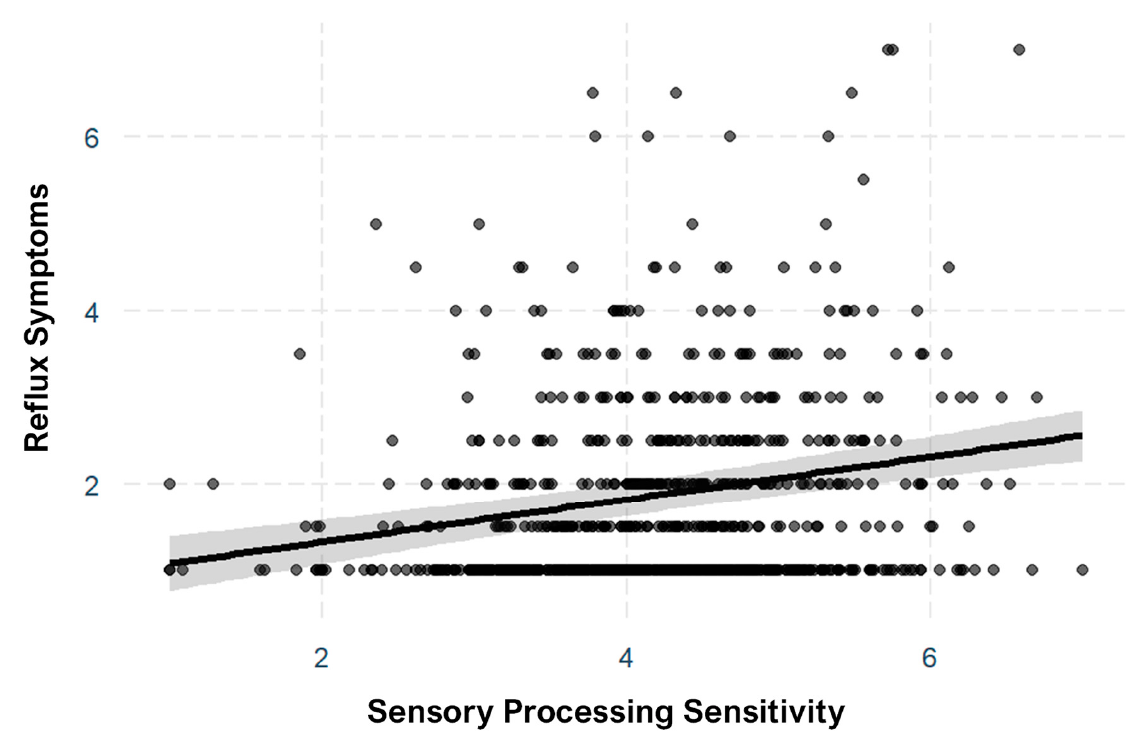
Figure A1. A Plot of the Regression Line Showing the Relationship between the Reflux Symptoms and Sensory Processing Sensitivity.